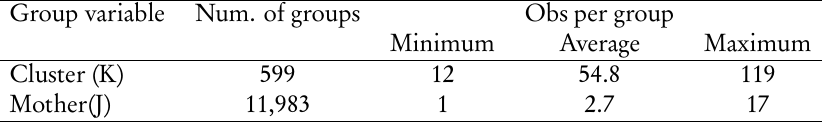
Mixed-effects logistic regression (Num. of obs =